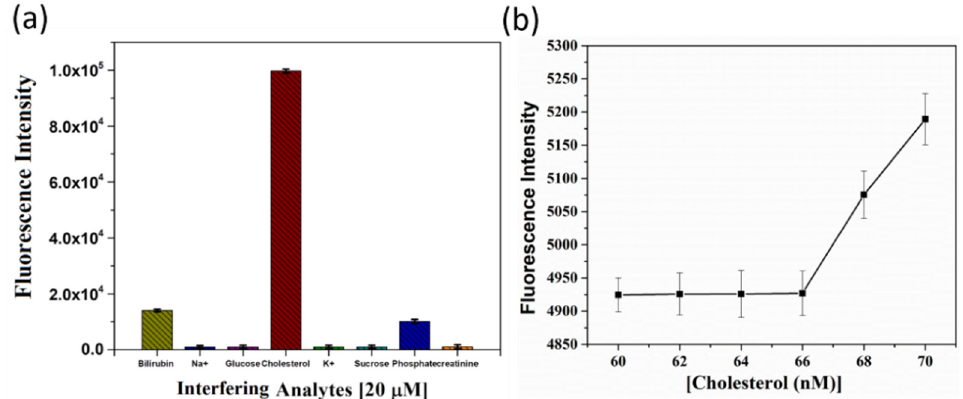
Figure 6. Practicability of the OFP-CD-based nanoarchitectonic sensor for cholesterol detection . ( a ) Bar diagram depicting selectivity of the OFP-CD-based probe over several interfering agents (at a concentration of 20 µM) towards cholesterol sensing in water. ( b ) Evolution of the fluorescence intensity of OFP-CD pre-quenched with dabsyl chloride in the presence of nanomolar concentrations of cholesterol in water, enabling assessment of the LOD of the sensor.